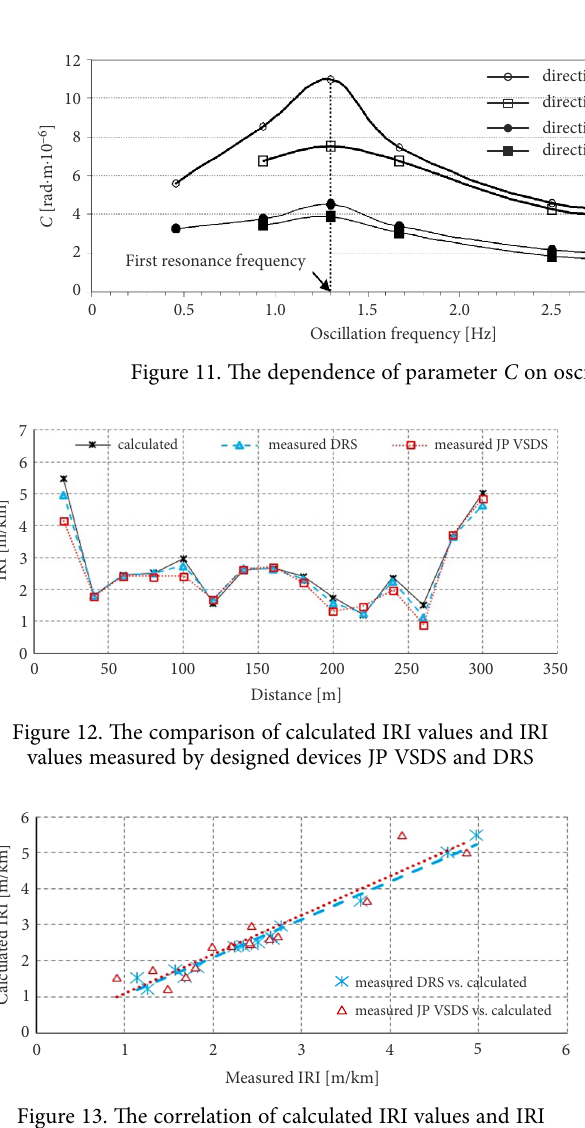
Figure 13. The correlation of calculated IRI values and IRI values measured by designed devices DRS and JP